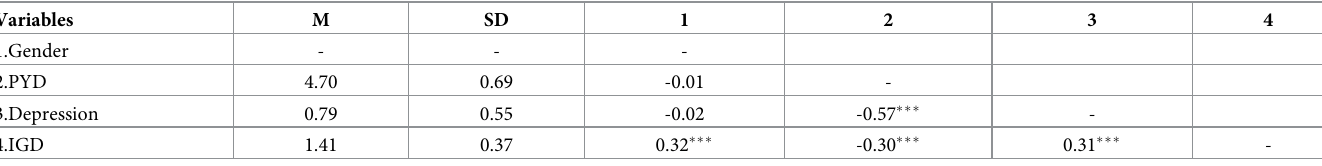
Table 1. Descriptive statistics and correlations of the key variables.